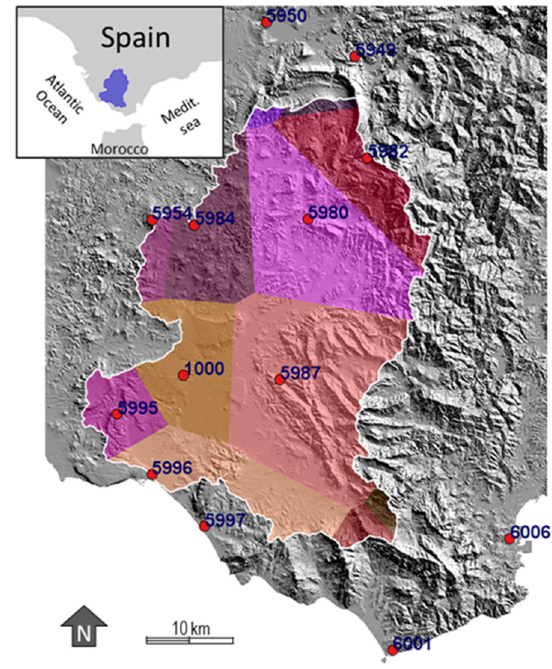
Figure 4. Thiessen polygons for determining station weight.